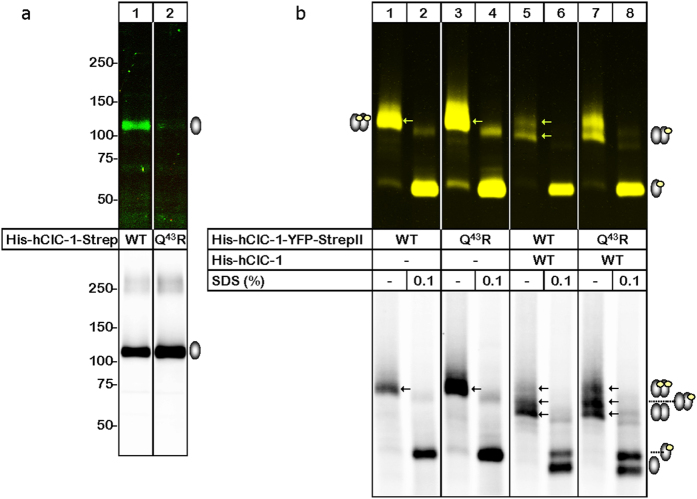
hClC-1 oligomerization is not impaired by Q43R.(a) SDS-PAGE gel (4–10% gradient) of WT and Q43R hClC-1 after expression in Xenopus oocytes and purification via StrepTactin chromatography. Proteins were visualized by scanning of plasma membrane-bound fluorescence (upper panel) or 35S-labeled total protein (lower panel). (b) Oligomeric state of WT and mutant hClC-1 channels. Indicated hClC-1 proteins were purified via metal affinity chromatography, resolved by BN-PAGE (4–12% gradient) and visualized by scanning of YFP fluorescence (upper panel) and 35S-labeled total protein (lower panel). The protein migration is shown both under native conditions and following partial denaturation after a 1-h incubation with 0.1% SDS at 37 °C, as indicated. The gray ovals without and with yellow balls schematically illustrate YFP-less and YFP-fused hClC-1, respectively, to indicate the native dimeric and denatured protomeric states of the corresponding protein bands. The data shown represent samples run on the same SDS-PAGE gel or BN-PAGE gel; irrelevant lanes were cropped from the figure as indicated by vertical lines. The respective source images of the individual gels are shown in Supplemental Fig. S3a and b.